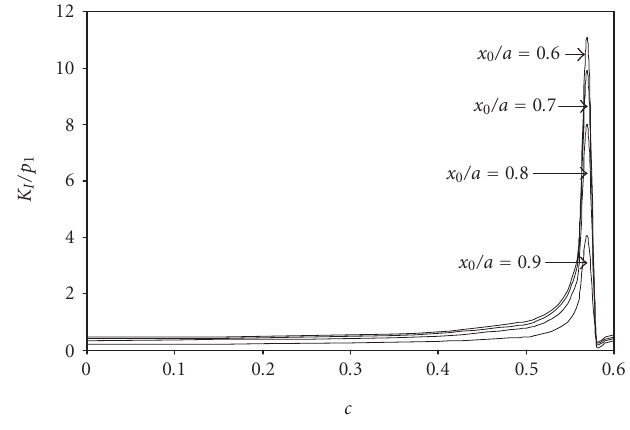
Figure 4.2 Plot of K I /p 1 versus c for di ff erent x 0 /a , h = 4, p 2 /p 1 = 0 . 5.